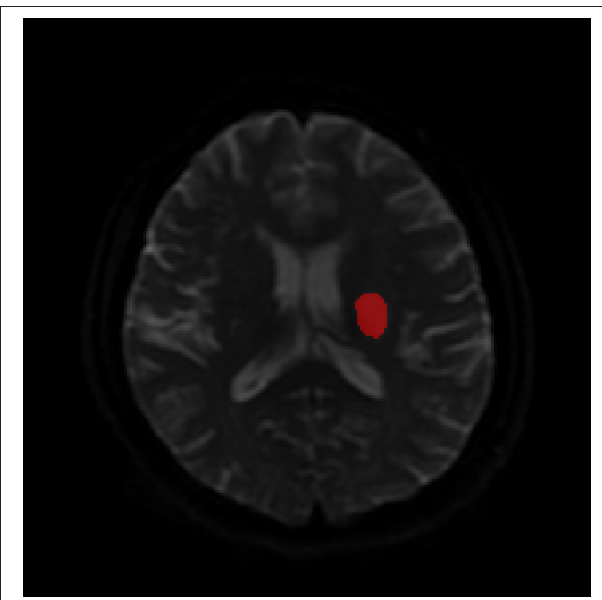
FIGURE 1 | An example of infarct volume views on diffusion-weighted imaging